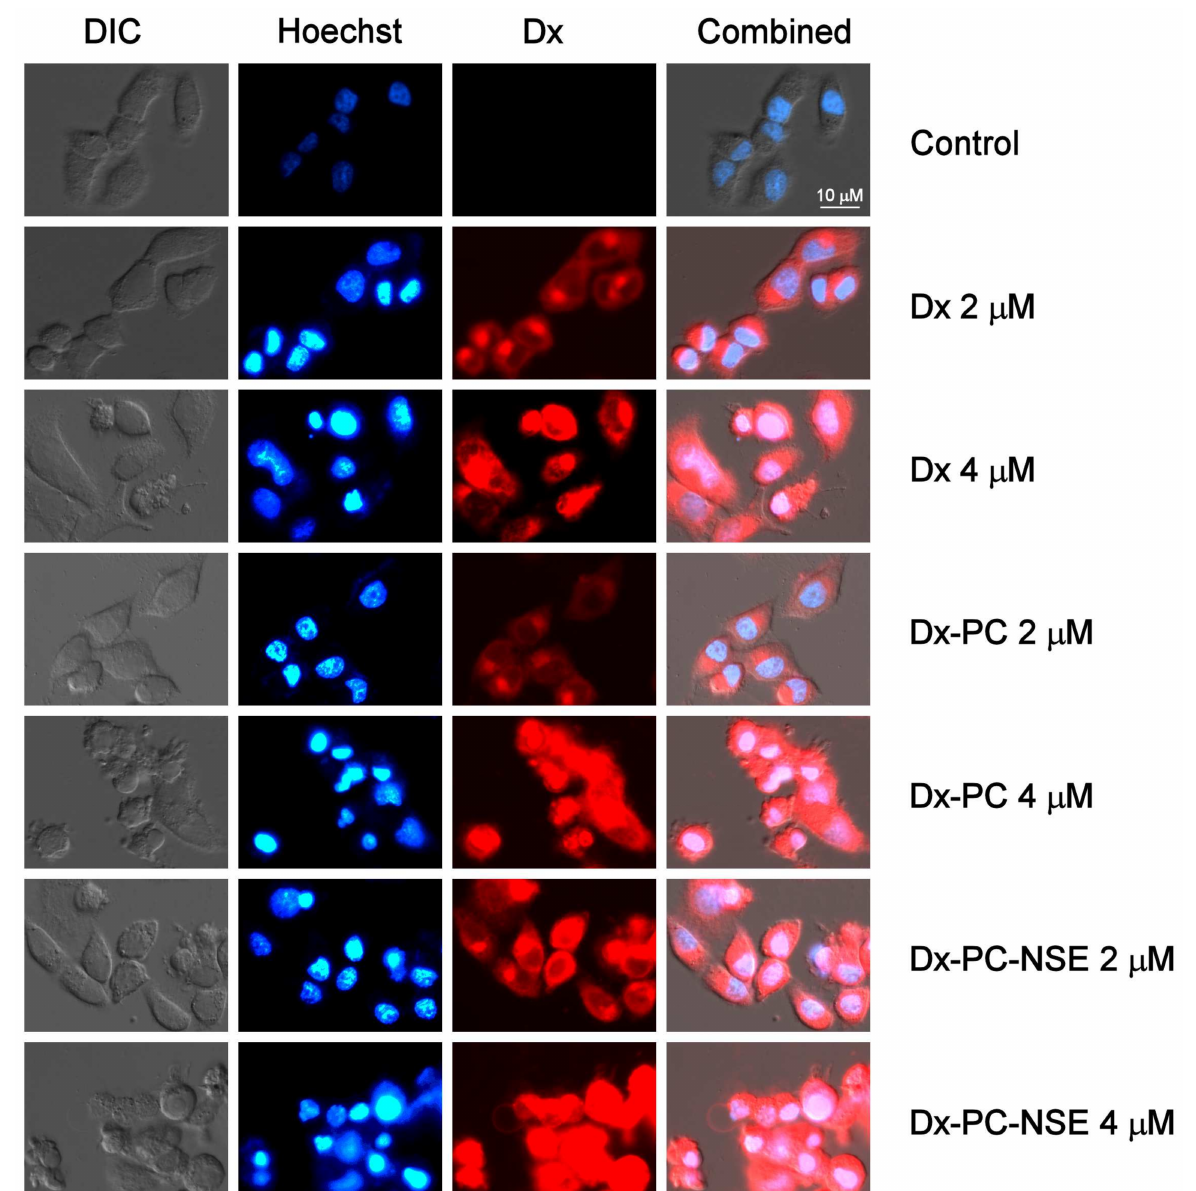
Figure 6. Changes in nucleus ultrastructure and Dx accumulation in HeLa cells under treatment with the indicated concentrations of Dx, Dx-PC, Dx-PC-NSE. Hoechst 33342 staining, fluorescent microscopy, 6 h incubation, ×